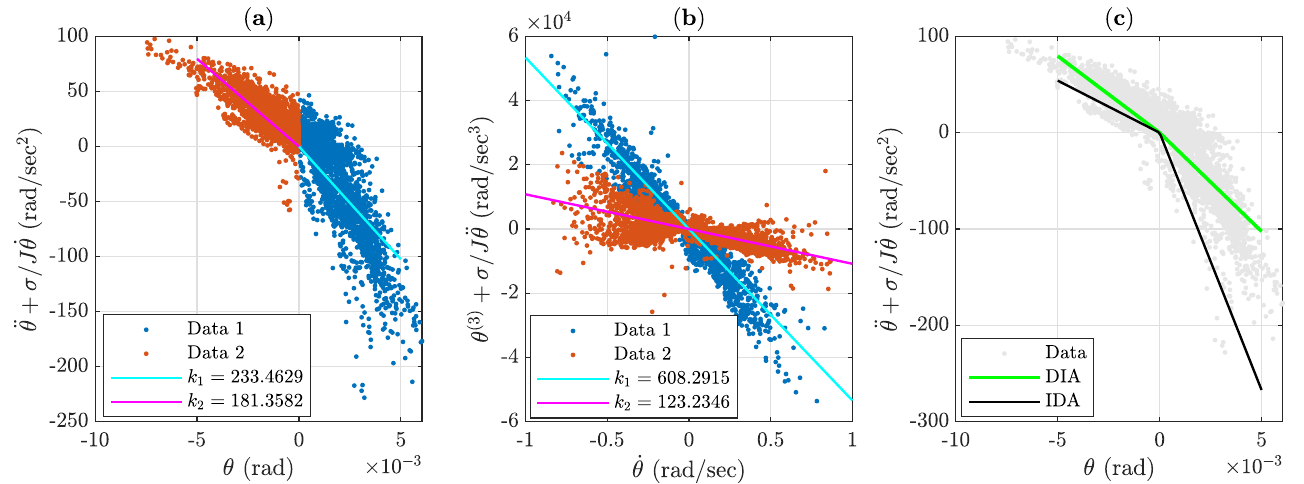
Figure 8. Results of the nonlinear beam identification with DIA and IDA. In both cases, Data 1 corresponds to negative tilt angle θ , Data 2 corresponds to positive tilt angle θ . Panel ( a ) illustrates results of DIA, panel ( b ) illustrates results of IDA, both results are shown in the panel ( c ). Being compared with IDA, DIA underestimates k 1 and overestimated k 2 , which corresponds to dynamics closer to harmonic oscillations rather then nonlinear